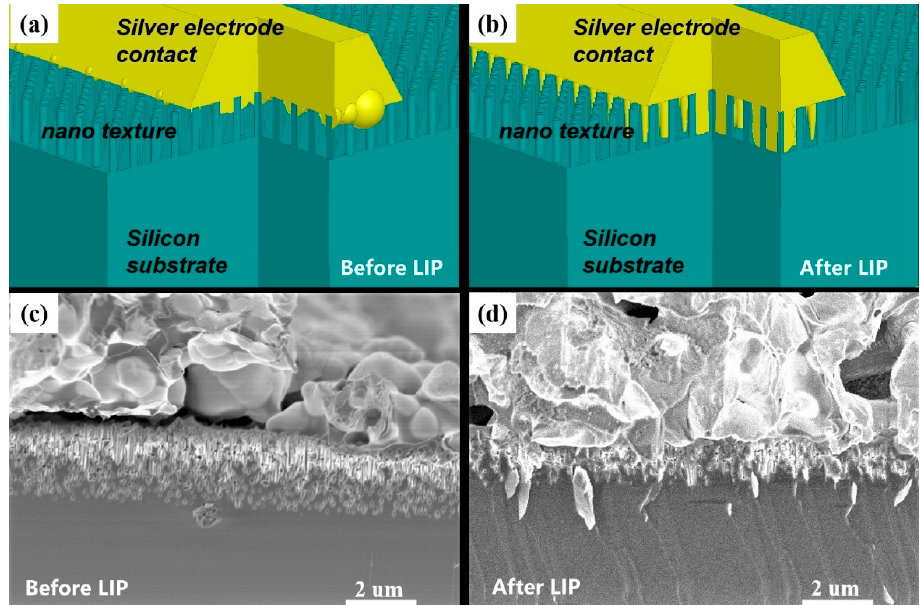
Figure 8. Schematic images of interface between electrode and nanotextured silicon substrate ( a ) before LIP and ( b ) after LIP. SEM photographs of the interface ( c ) before and ( d ) after LIP.